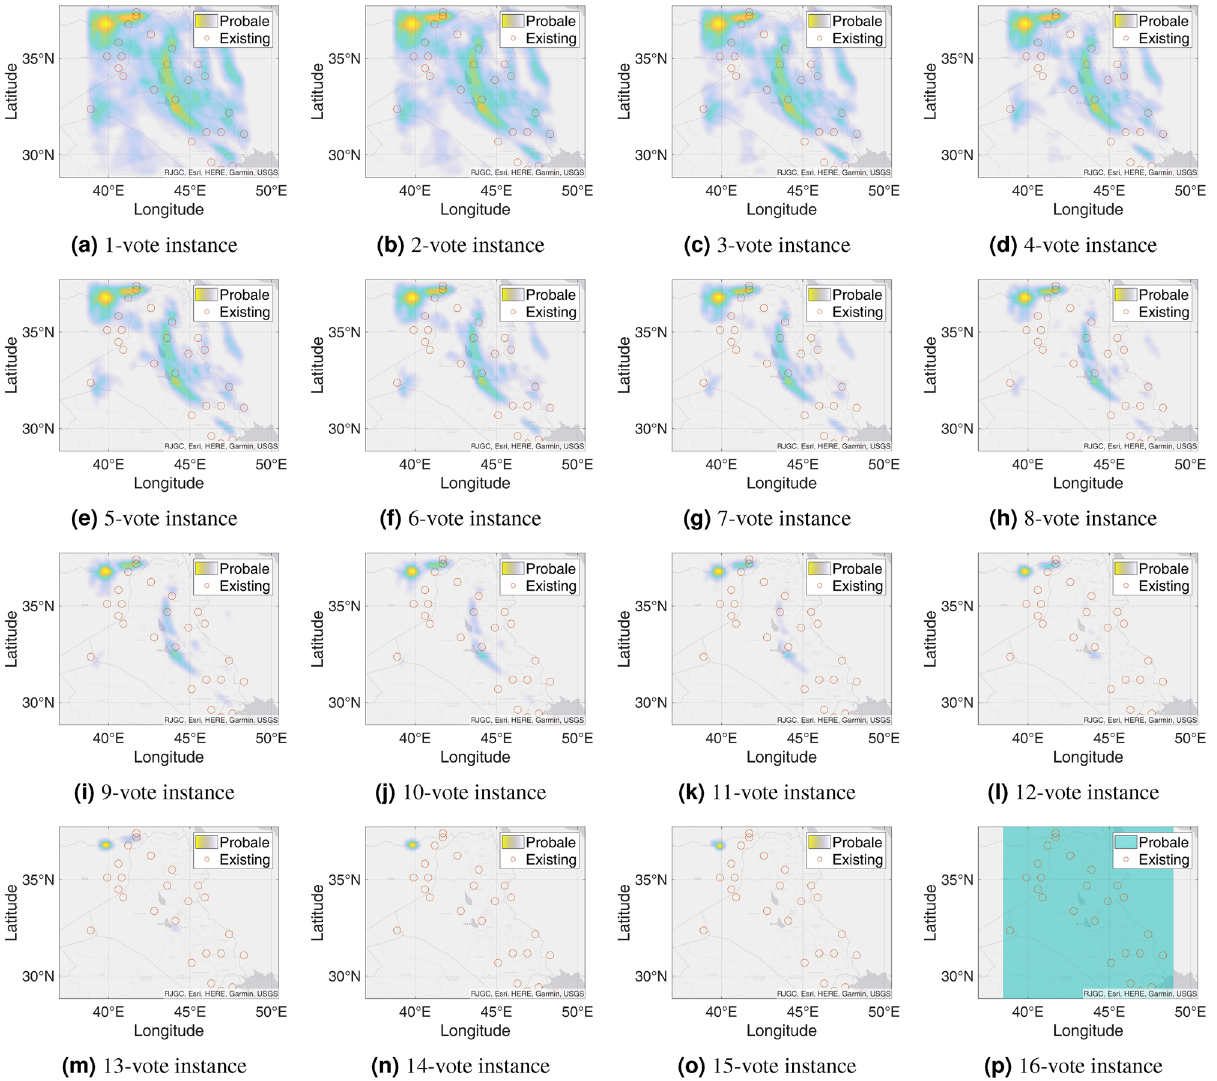
Figure 9. Probable petroleum deposits based on the frequency of 1 to 16 votes over our 16 best-performing models from the matrix-based analysis (the figures are created using MATLAB 2021a 51